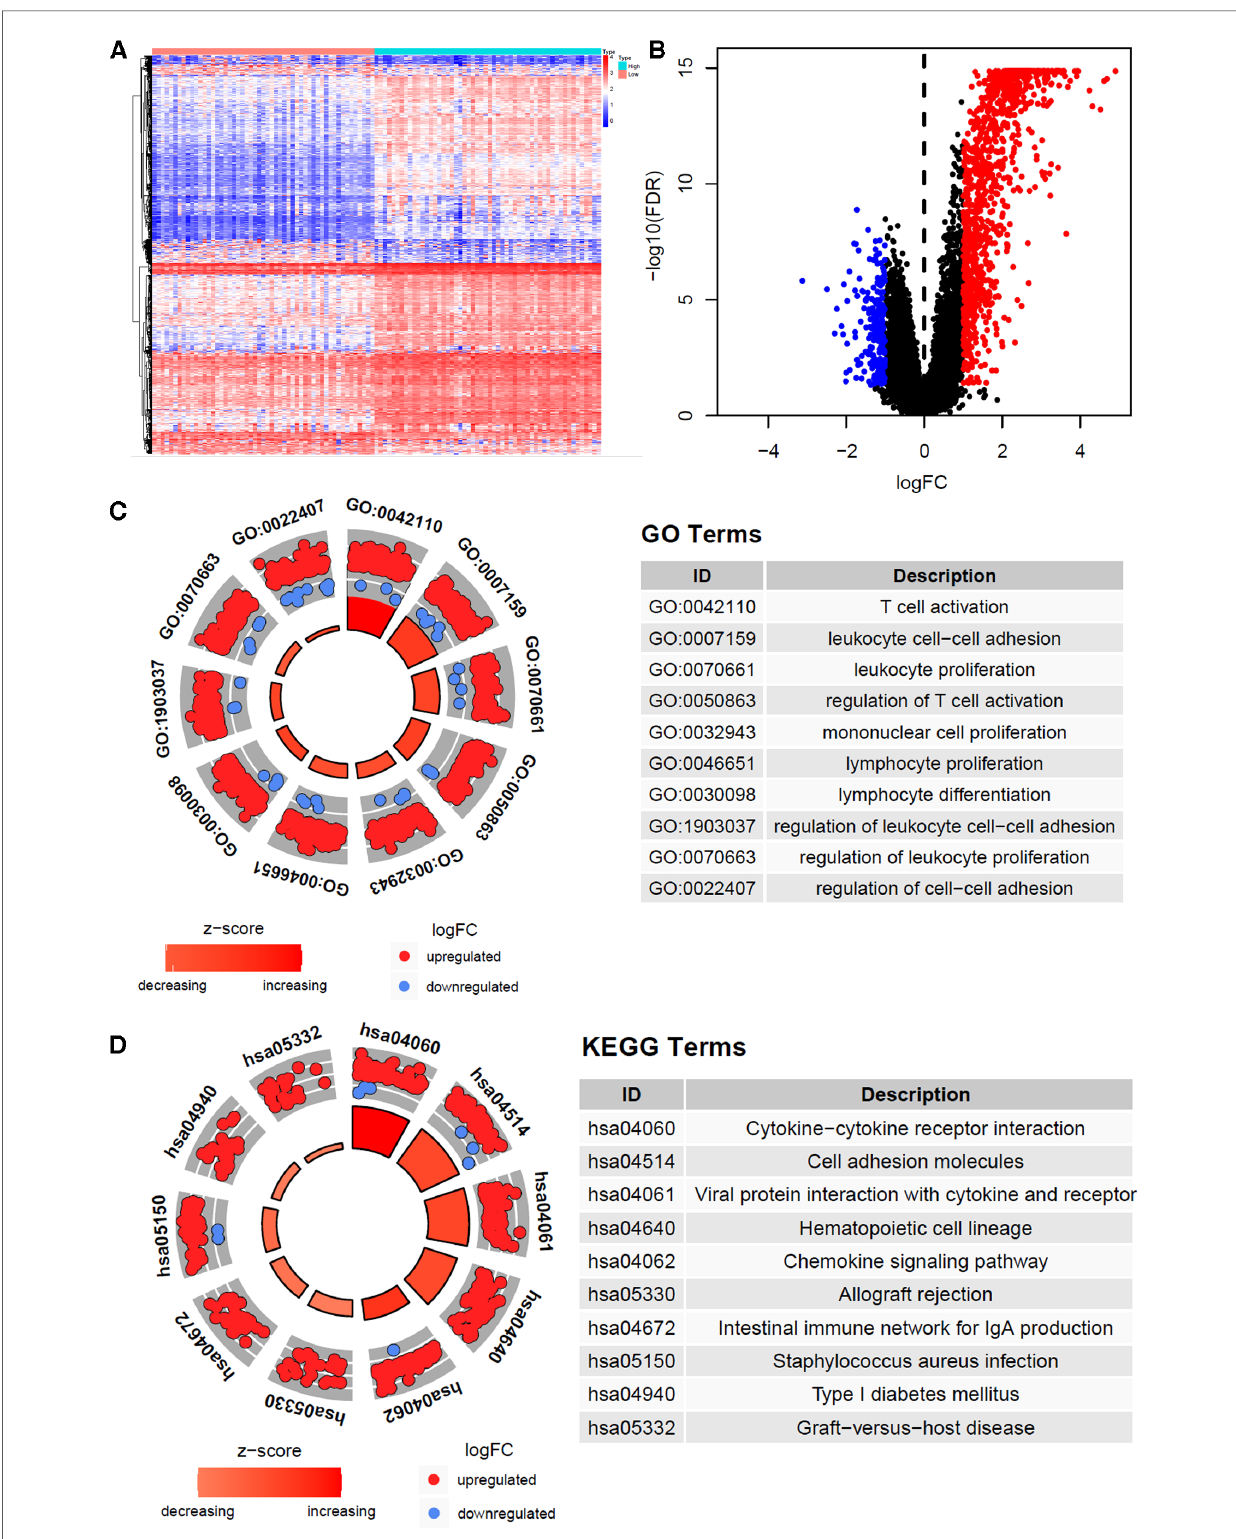
FIGURE 3 Gene expression heatmap, volcano map and function enrichment analysis of differentially expressed genes. ( A ) The heat map of differentially expressed genes of high and low immune subtypes in gastric cancer (|log FC|>1, P <0.05). ( B ) Volcano map of differentially expressed genes. ( C ) Differentially expressed genes Circle diagram of GO and KEGG pathway enrichment